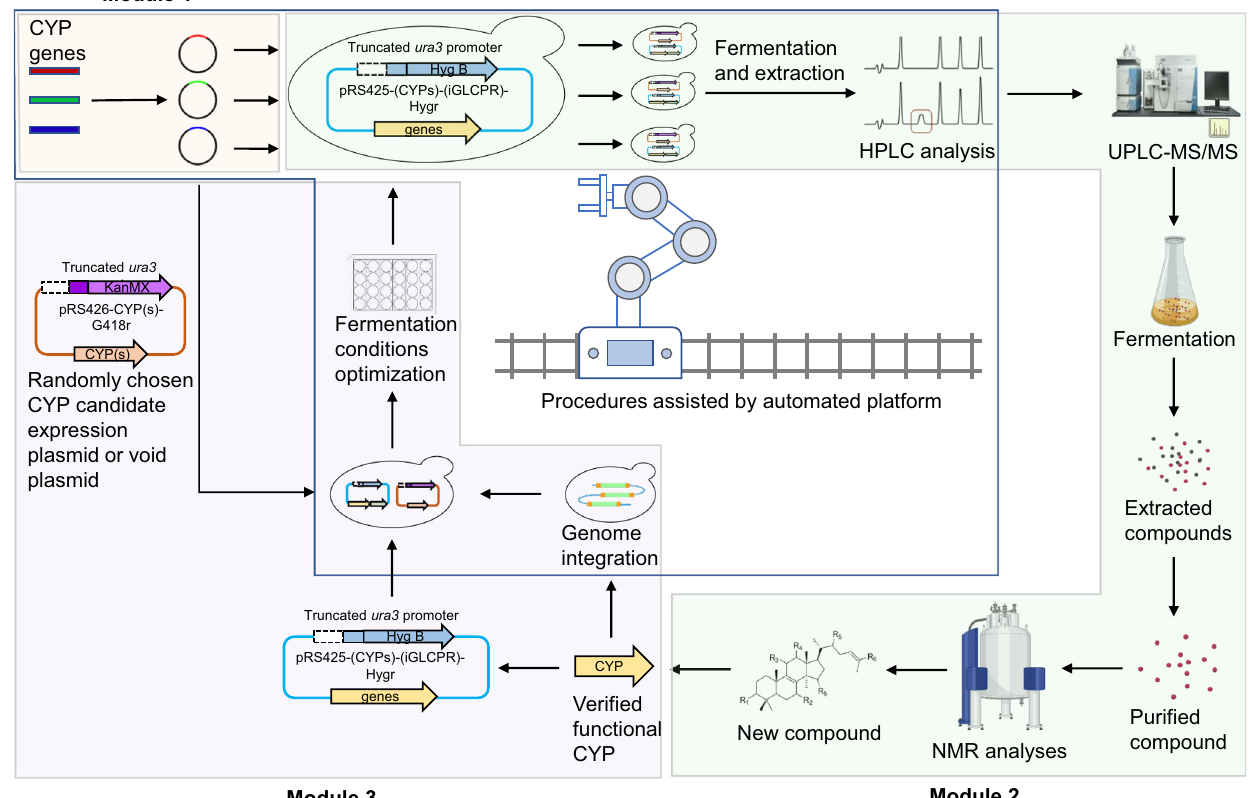
Fig. 2 | Schematic illustration of the iterative screening of functional CYPs facilitated by an automated system. The platform included three modules: the constructionofCYPexpressionplasmids(module1,highlightedinlightpink),high- throughput in vivo screening of functional CYPs (module 2, highlighted in light green), and metabolic engineering of a yeast host compatible with the next round ofscreening(module3,highlightedinlightpurple).Indetail,thecodingsequences of CYPs were ampli fi ed from cDNA of G. lucidum and cloned into the plasmid pRS426-HXT7p-FBA1t-G418r to form a CYP expression plasmid library. The corre- sponding plasmidswereintroduced into a yeast chassis. The resultant strains